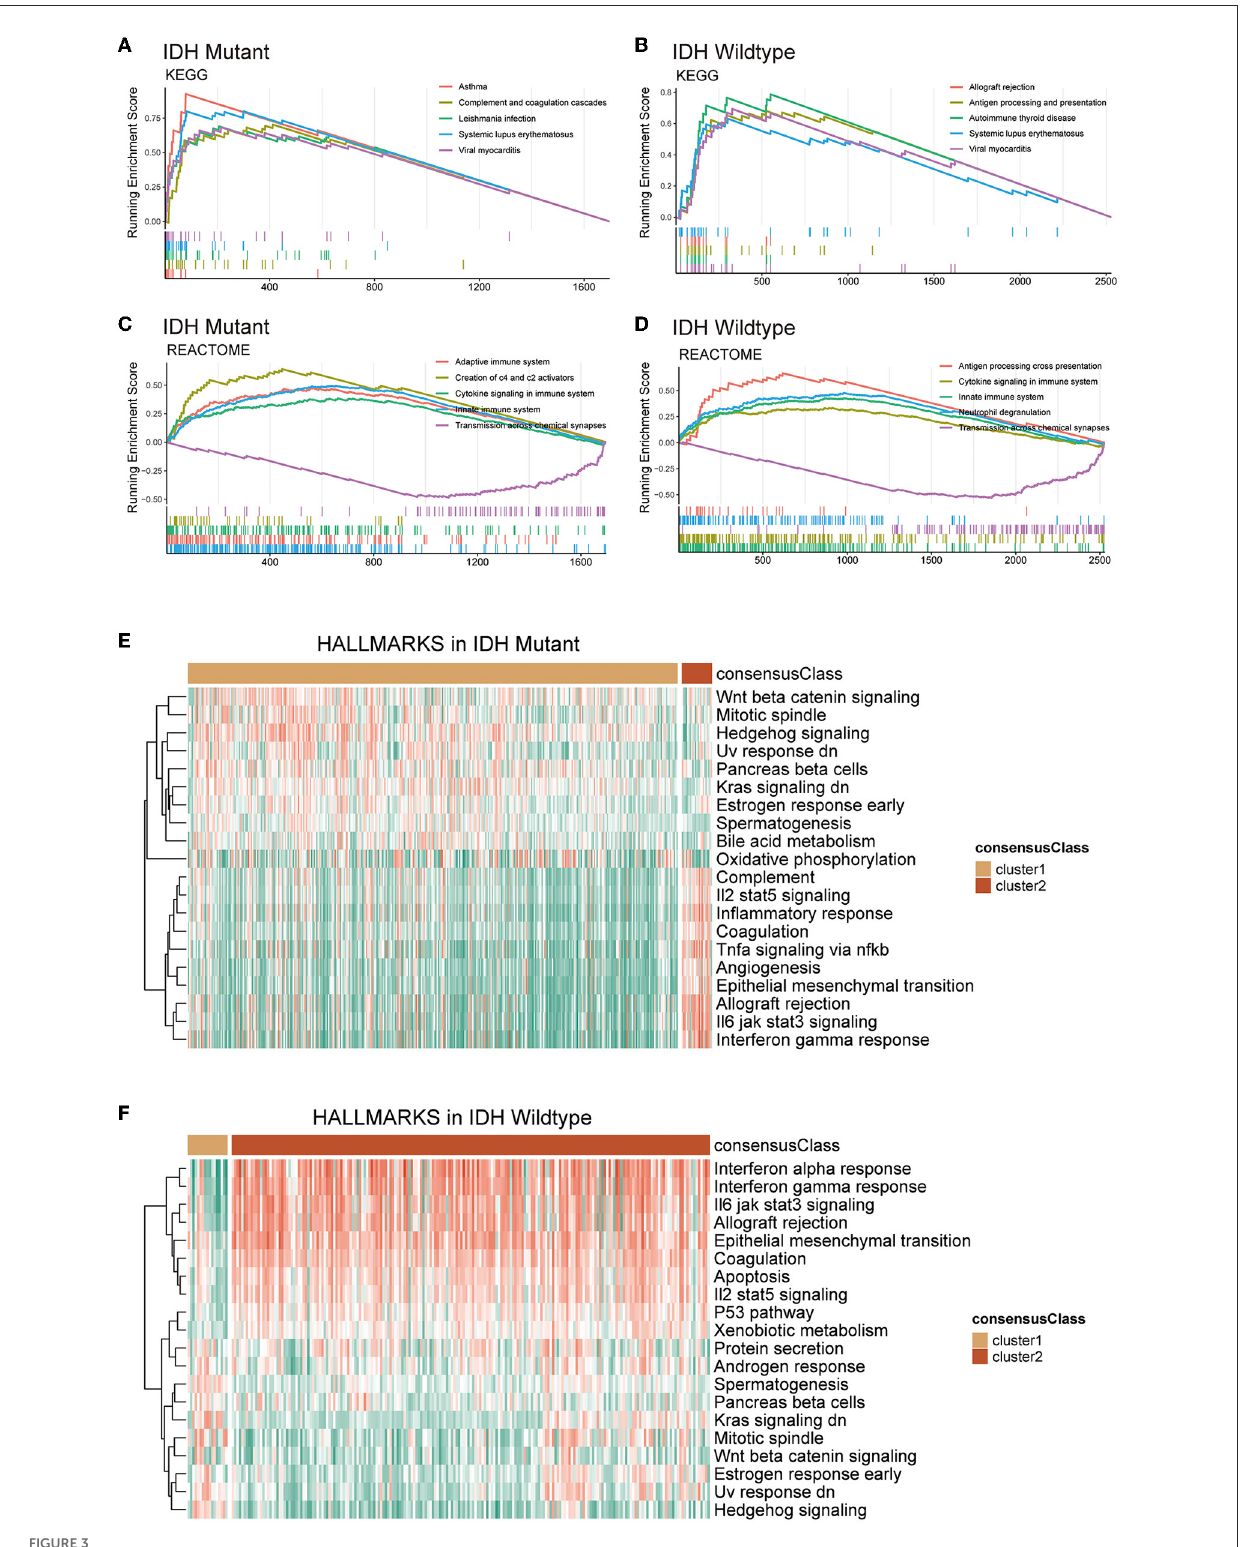
FIGURE3 Functional enrichment analysis of DEGs between clusters 1 and 2 based on IDH mutation status. Top 5 KEGG pathways (A, B) and reactome pathways (C, D) based on GSEA. The heatmap of GSVA based on Hallmark gene sets in IDH-mutant (E) and IDH-wildtype (F) gliomas. DEG, differentially expression gene; IDH, isocitrate dehydrogenase; KEGG, Kyoto Encyclopedia of Genes and Genomes; GSVA, gene set variation analysis; GSEA, gene set enrichment